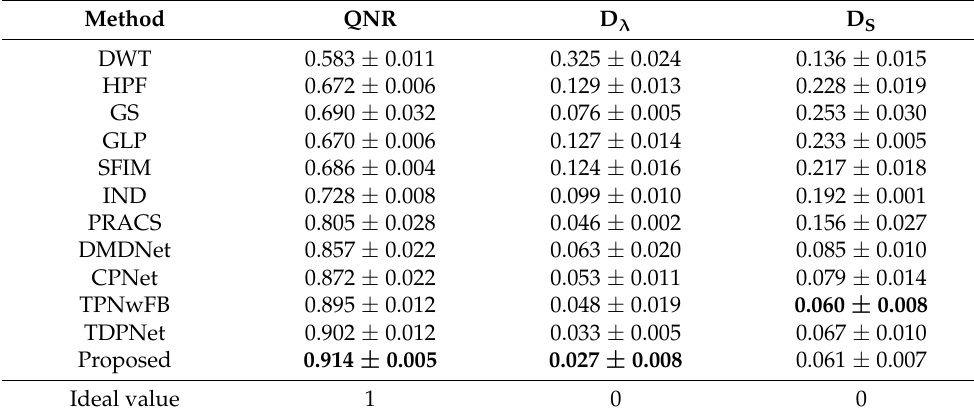
Figure 14. Results for four bands using the QuickBird real dataset (resolution, 256 × 256 pixels): ( a ) upsampled LRMS; ( b ) PAN; ( c ) DWT; ( d ) HPF; ( e ) GS; ( f ) GLP; ( g ) SFIM; ( h ) IND; ( i ) PRACS; ( j ) DMDNet; ( k ) CPNet; ( l ) TPNwFB; ( m ) TDPNet; ( n ) ours algorithm. Table 6. Evaluation results of the QuickBird real dataset (best results in